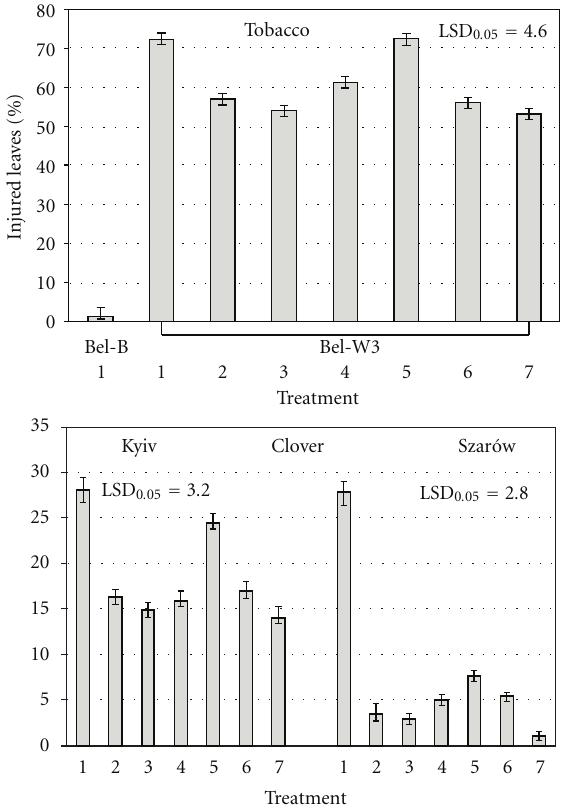
Figure 1: Ozone-induced visible injuries on leaves of clover and tobacco sprayed with distilled water (1), solutions of EDU, 150 mgL − 1 (2), “Emistym C”, 150 mgL − 1 in Kyiv and 30mgL − 1 in Szar´ow (3), “Agrostymulin”, 150 mgL − 1 in Kyiv and 30mgL − 1 in Szar´ow (4), “Quadris”, 300mg L − 1 in Kyiv and 150 mgL − 1 in Szar´ow (5), “Flint”, 300 mgL − 1 in Kyiv and 150 mgL − 1 in Szar´ow (6), “Strobi”, 300 mgL − 1 in Kyiv and 150mg L − 1 in Szar´ow (7) on the last day of exposure to ambient ozone. Vertical bars represent standard error. LSD 0,05 : least significant di ff erence at P < 0 . 05. Ozone protective e ff ect of “Emistym C” and